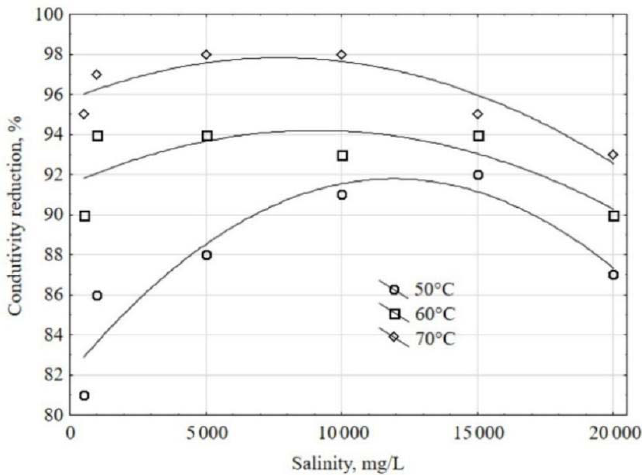
Figure 8. Percentage reduction in conductivity of treated water as a function of the salinity of feed water of the bench ‐ scale ultrasonic prototype for boiler water treatment.